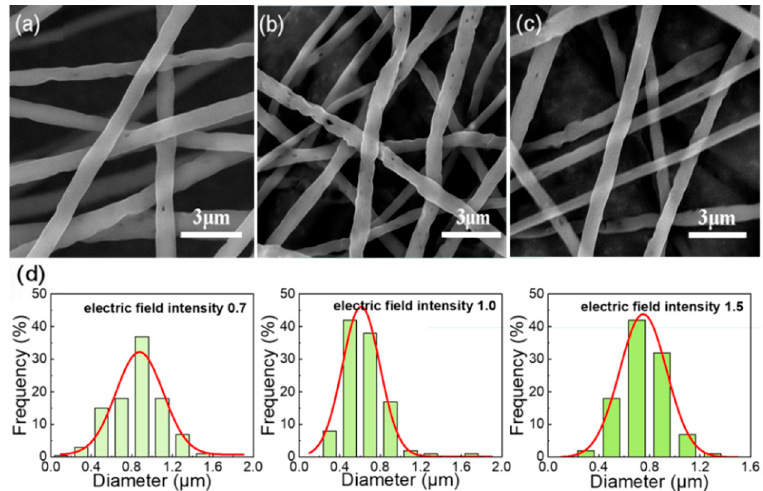
Figure 4. SEM images of the electrospun fibrous membrane with 14% solution concentration at different voltage, ( a ) 11 kV; ( b ) 16 kV; ( c ) 24 kV; ( d ) Gaussian fitting curve of fiber diameter distribution prepared under different voltages.